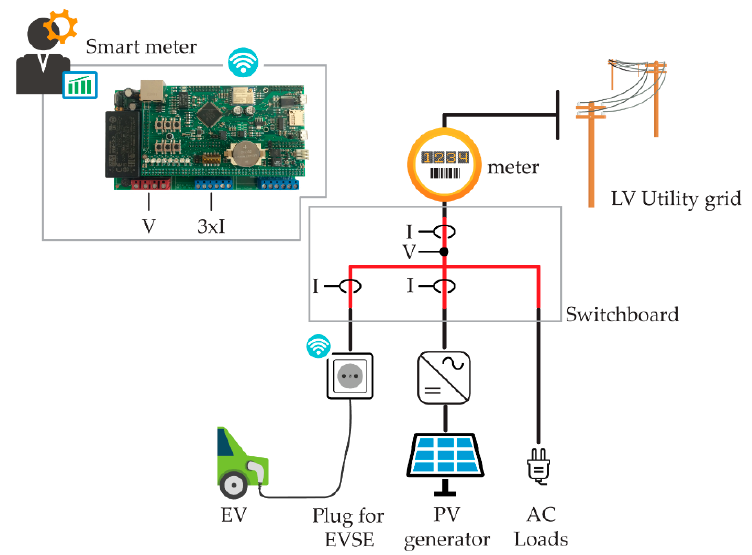
Figure 6. Connection of smart meter at a user’s home.